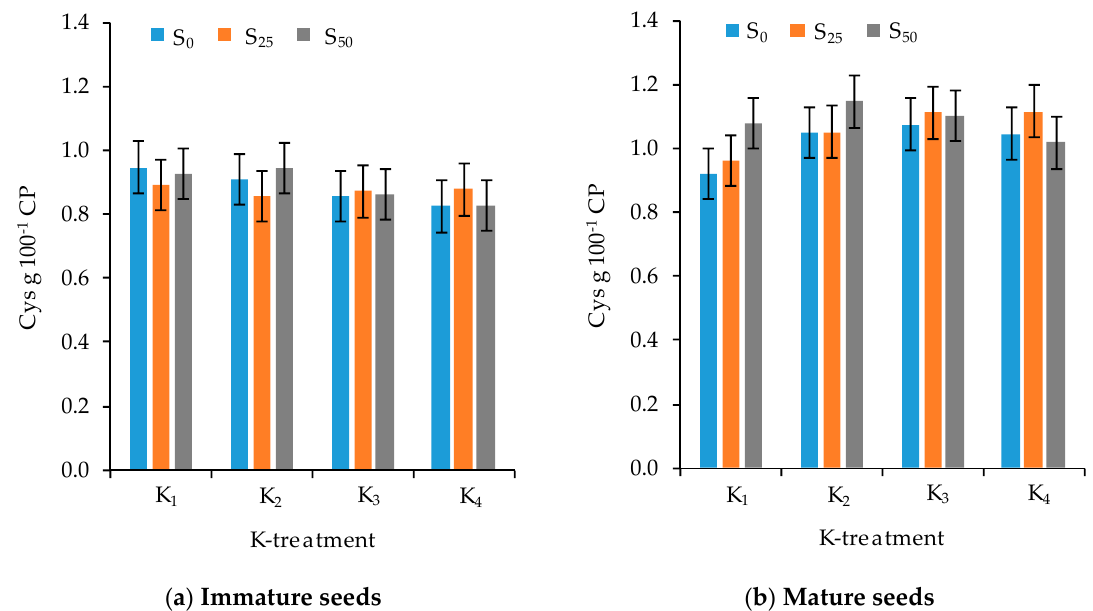
Figure 3. Effect of interaction between K and S application on Cys content in: ( a ) immature seeds; and ( b ) mature seeds. K 1 , K 2 , K 3 , and K 4 refer to levels of soil K availability and fertilization; S 0 , S 25 , and S 50 refer to sulfur application at rates of 0, 25, and 50 kg S ha − 1 , respectively. Letters indicate significant differences between treatments ( p < 0.05). Hatched bars represent 2 × standard error (SE) ranges.